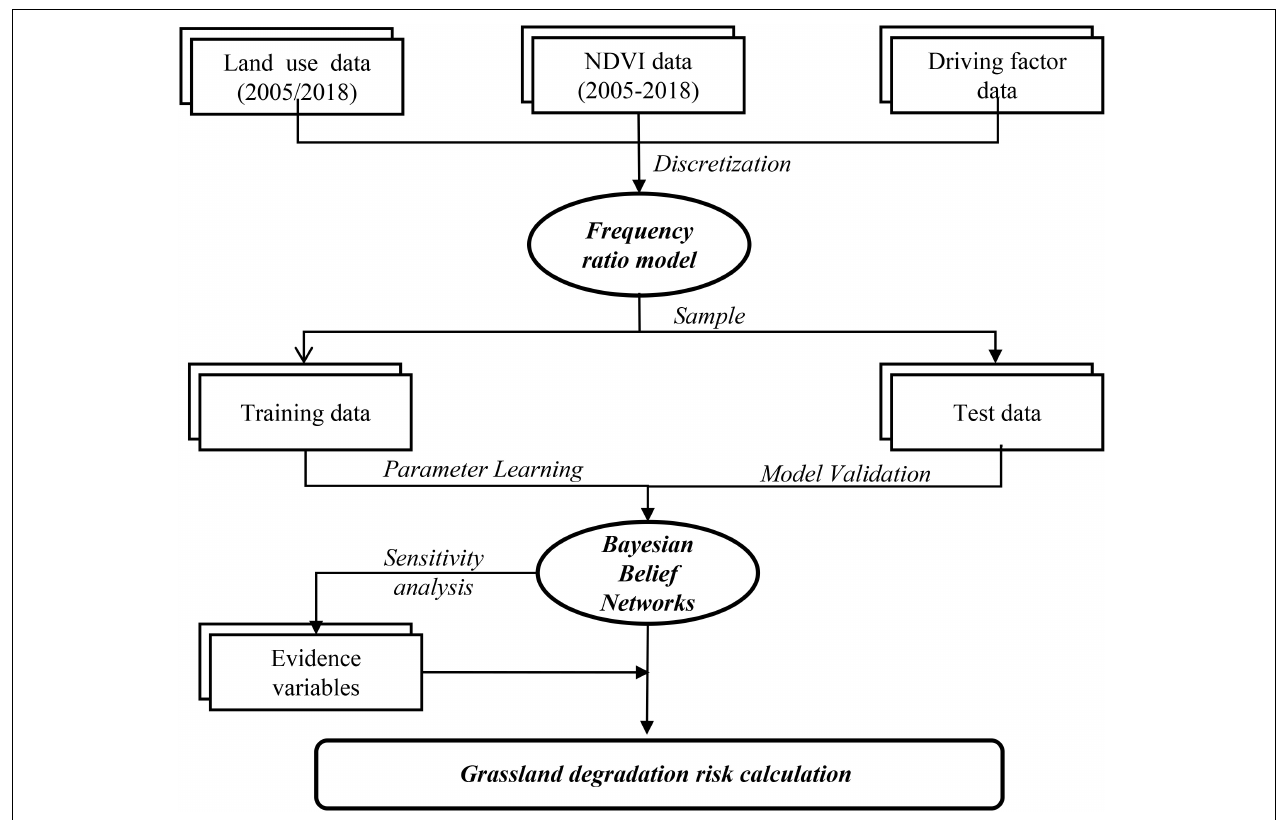
FIGURE 2 | Design and application framework of the BBN